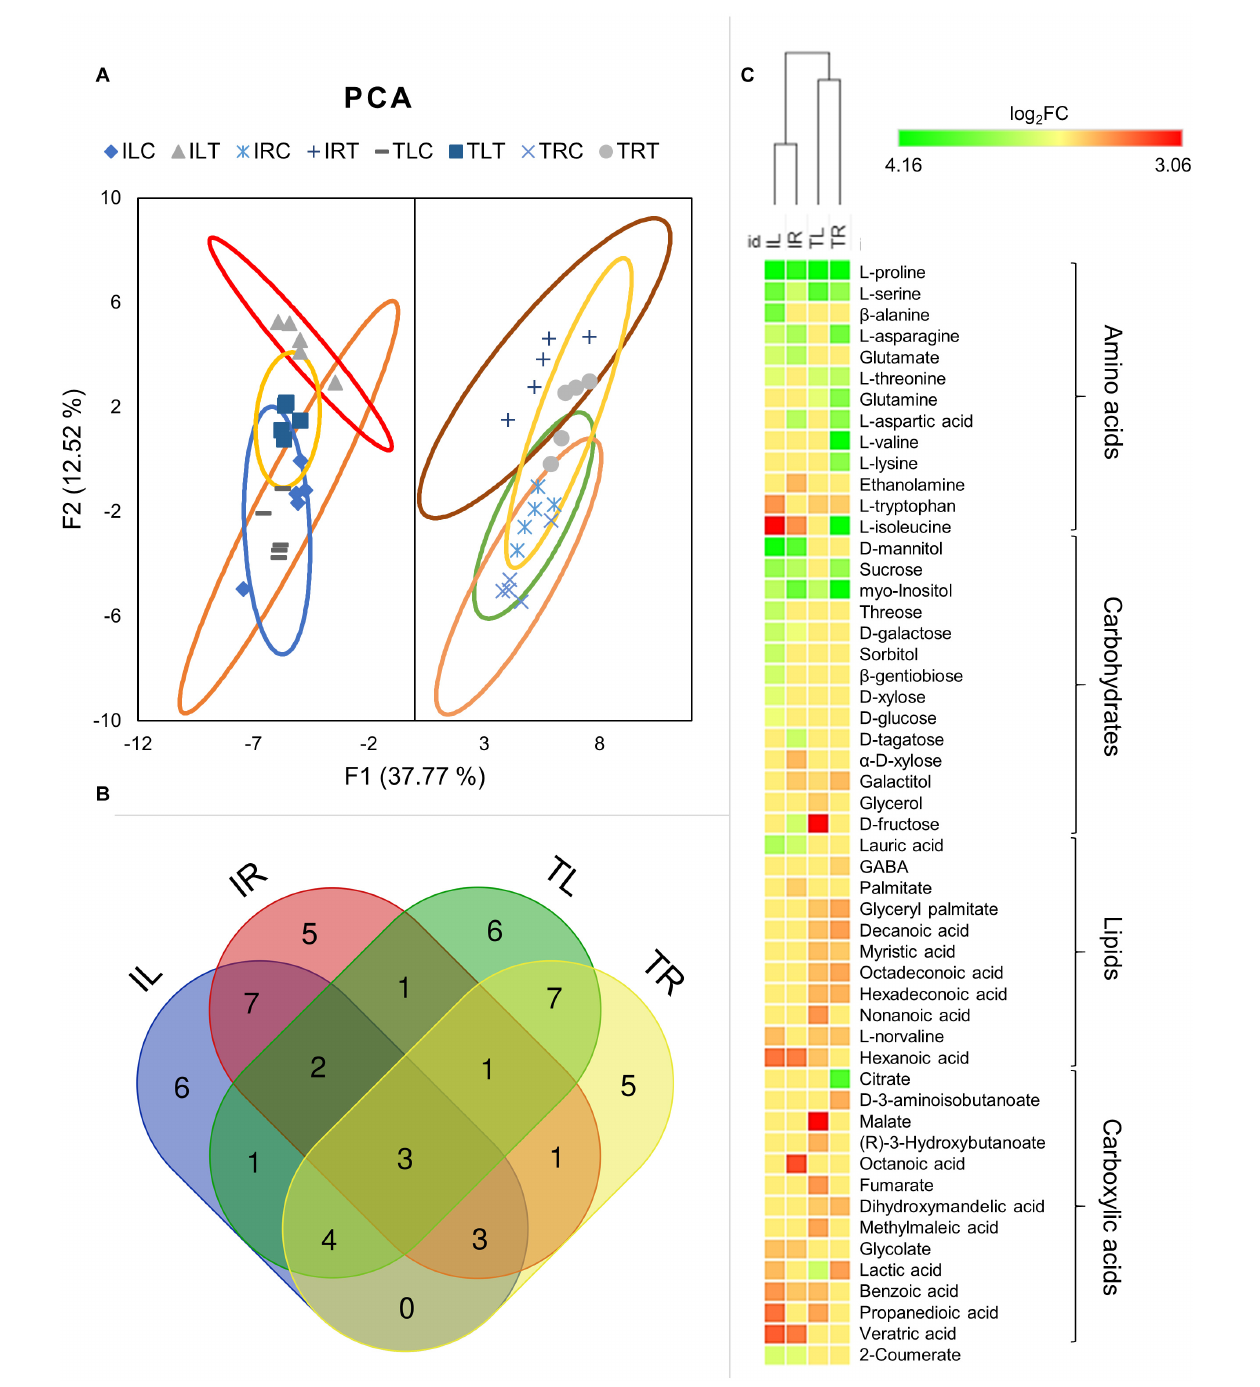
FIGURE 5 | Principal component analysis was employed to visualize the distinction of metabolic responses in different tissues and conditions (A) . Venn diagram displays the distribution of DADMs among tissues in salt stress (B) . Hierarchical clustering analysis of DADMs demonstrated the differential reaction of the two genotypes (C)